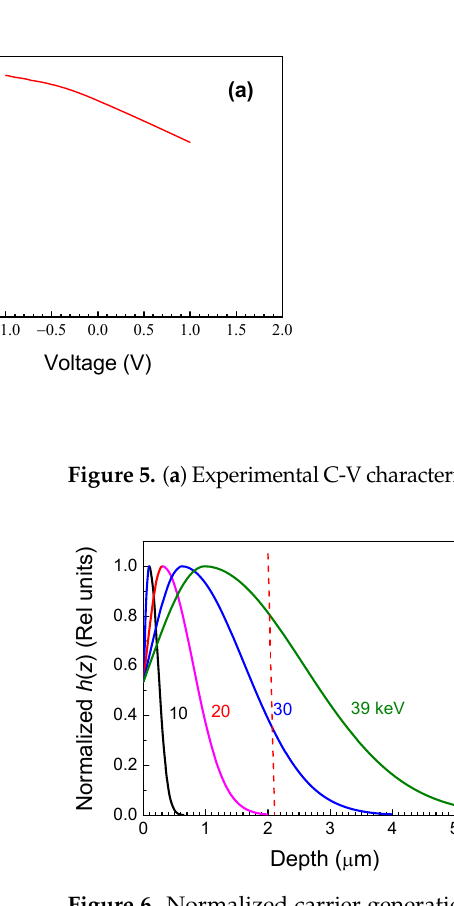
Figure 6. Normalized carrier generation rate calculated for different probing beam energies. The dashed red line shows the film thickness.